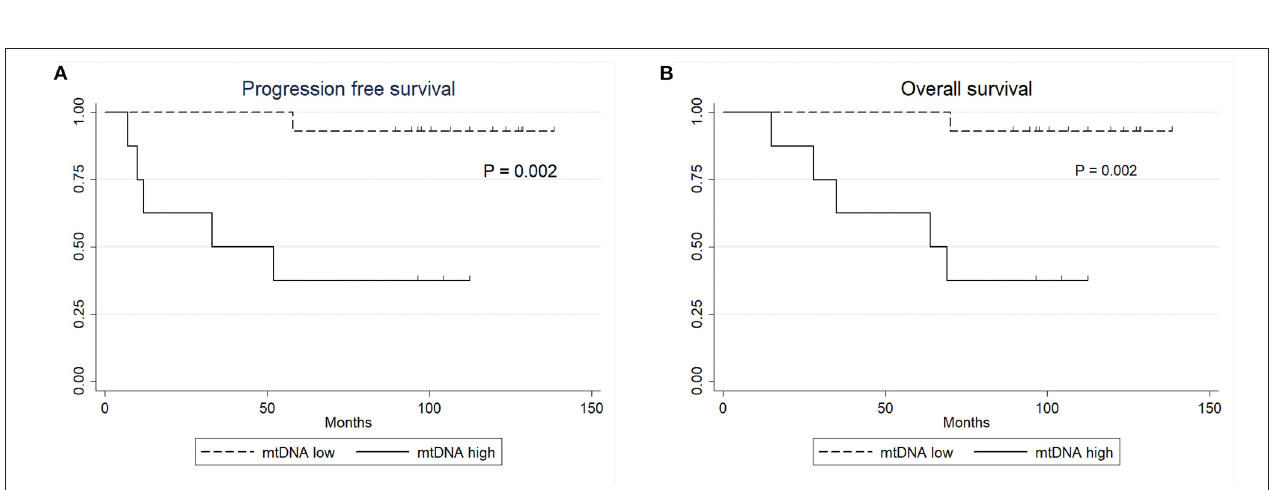
FIGURE 3 | Kaplan-Meier survival curves. (A) PFS of patients with post-operative radiation therapy by mtDNA content. (B) OS of patients with post-operative radiation therapy by mtDNA content.